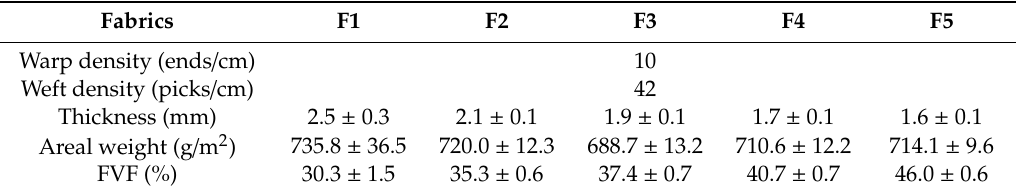
Table 3. The manufacturer’s specifications of all the dry fabrics. Fabrics F1 F2 Warp density (ends /